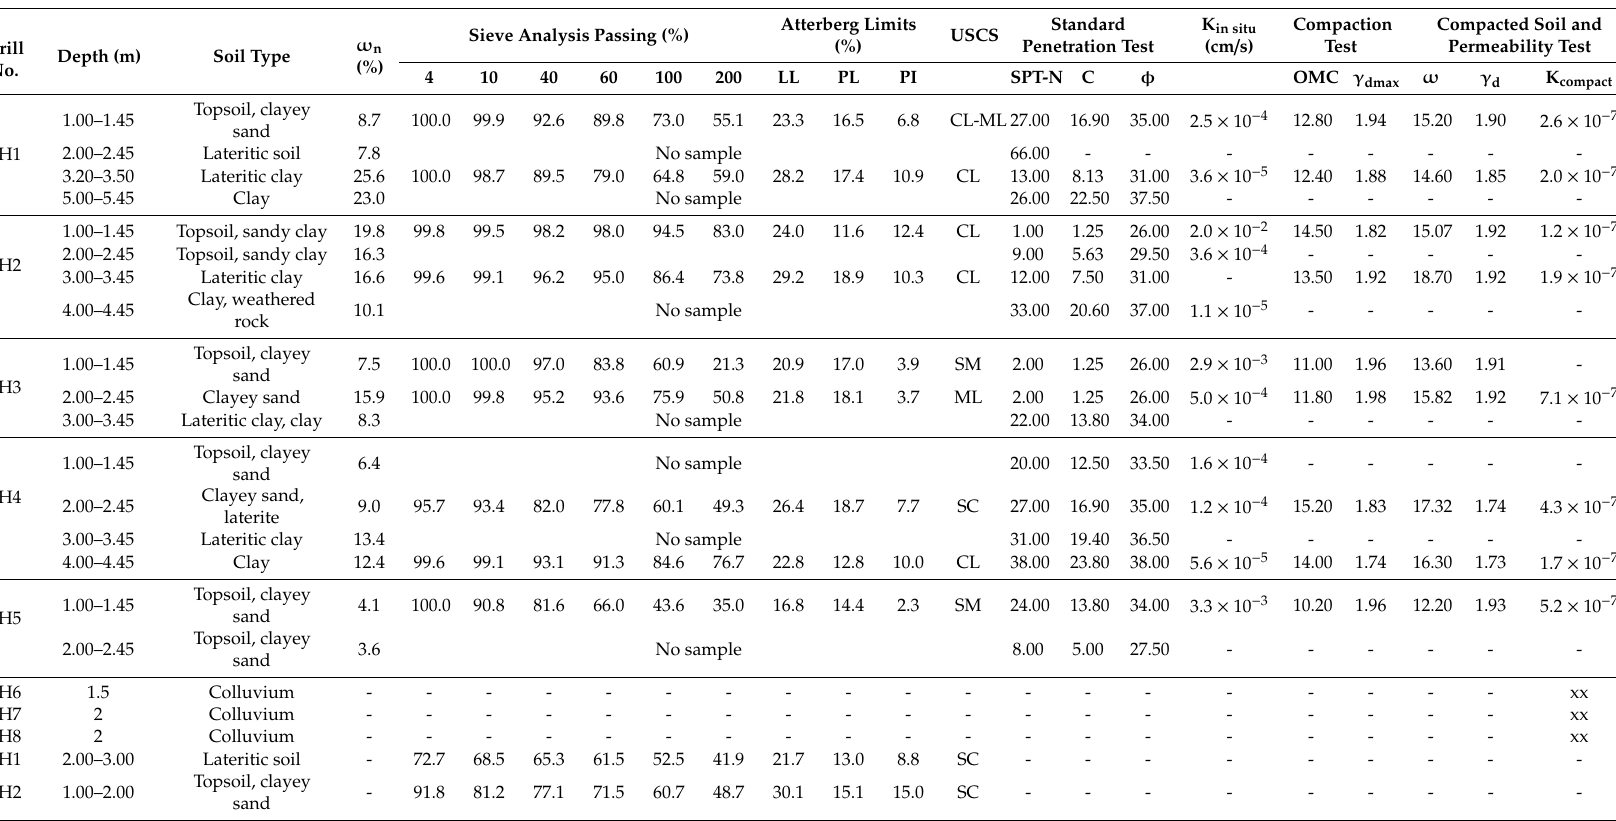
Table 2. In situ permeability, standard penetration testing, standard proctor compaction, and coe ffi cient of permeability after compaction testing results. Drill